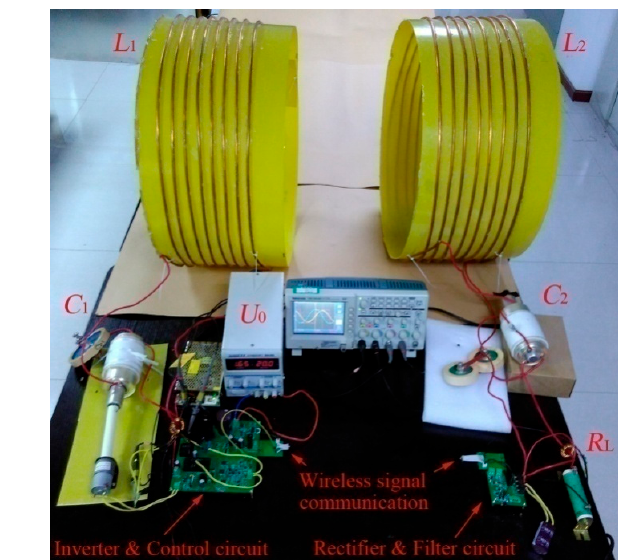
Figure 10. Photo of the experimental platform. Table 1. Types of components.